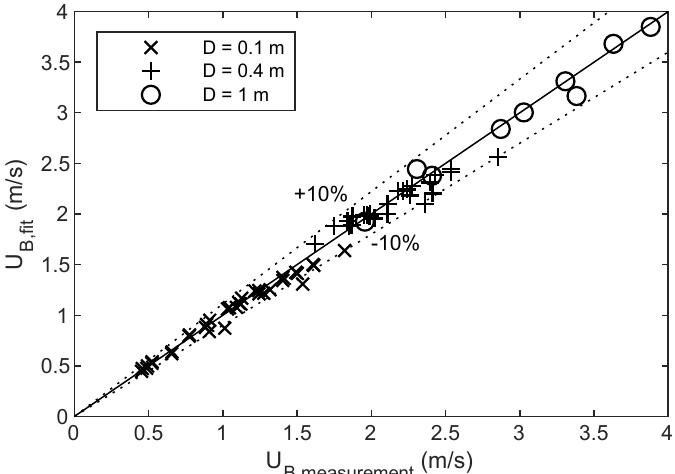
Figure 12. Parity plot of measured bubble velocities and fitted velocities as a function of the mean pierced length of the bubbles.